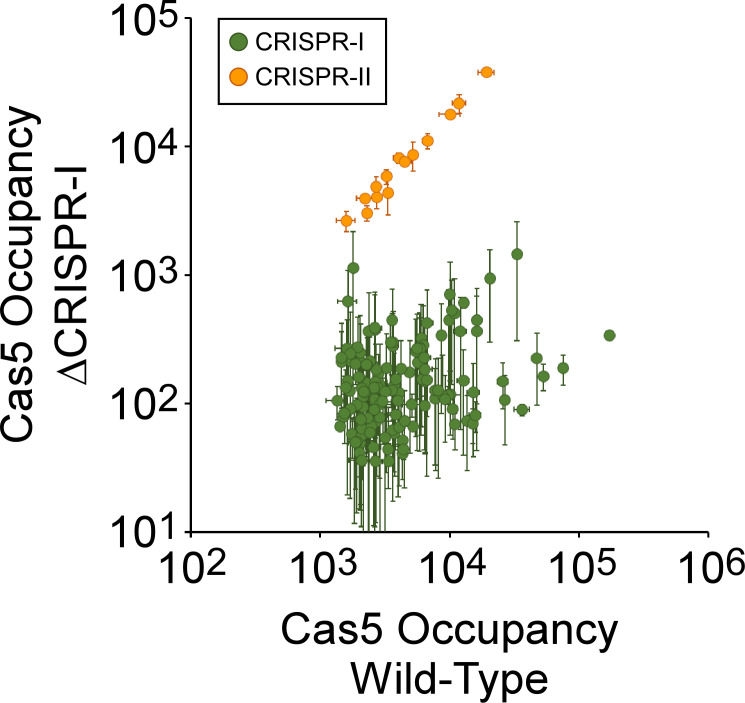
Confirmation of spacer assignments to Cas5- binding sites.Comparison of FLAG3-Cas5 ChIP-seq occupancy at off-target chromosomal sites in cells with an intact CRISPR-I array (AMD678; x-axis), and ΔCRISPR-I cells (AMD679; y-axis). Cascade binding associated with spacers from CRISPR-I is indicated by green datapoints. Cascade binding associated with spacers from CRISPR-II is indicated by orange datapoints. Values plotted are the average of two independent biological replicates. Error bars represent one standard-deviation from the mean.